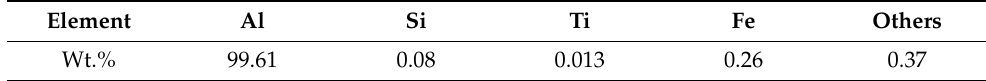
Table 1. Chemical composition of 1050 Al.